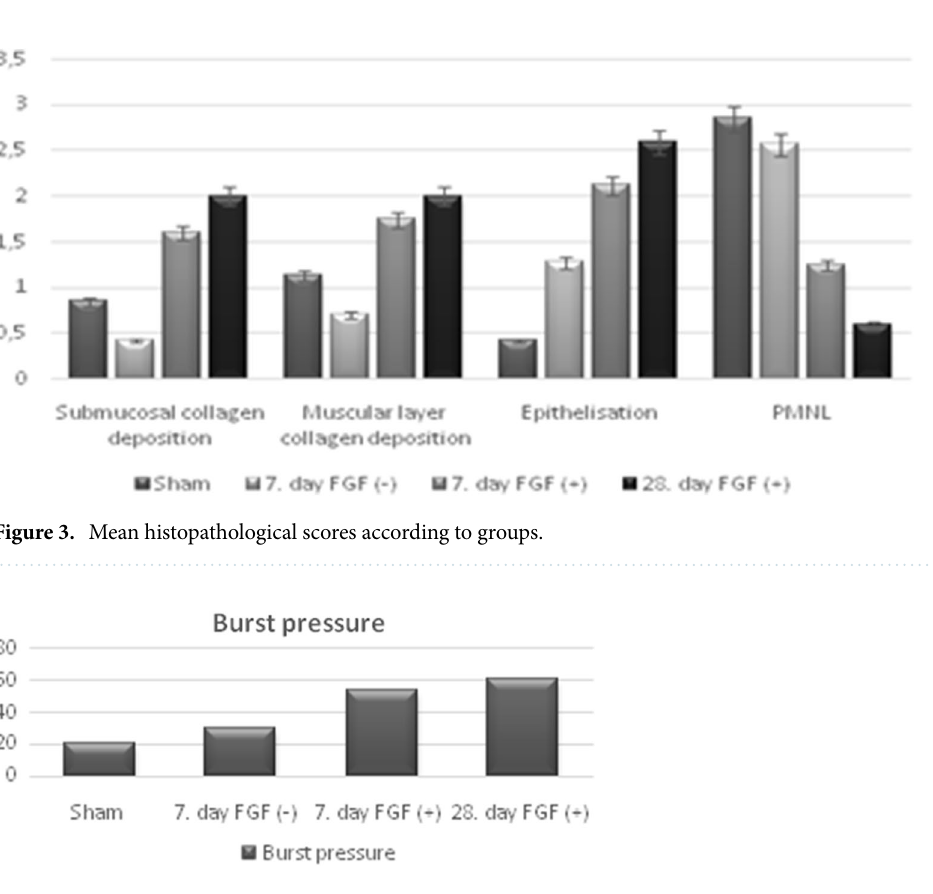
Figure 4. Differences of mean bursting pressure in the